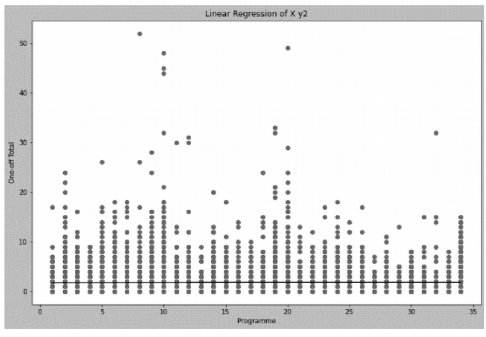
Figure 14. Linear Regression of X y2 in Finding 2